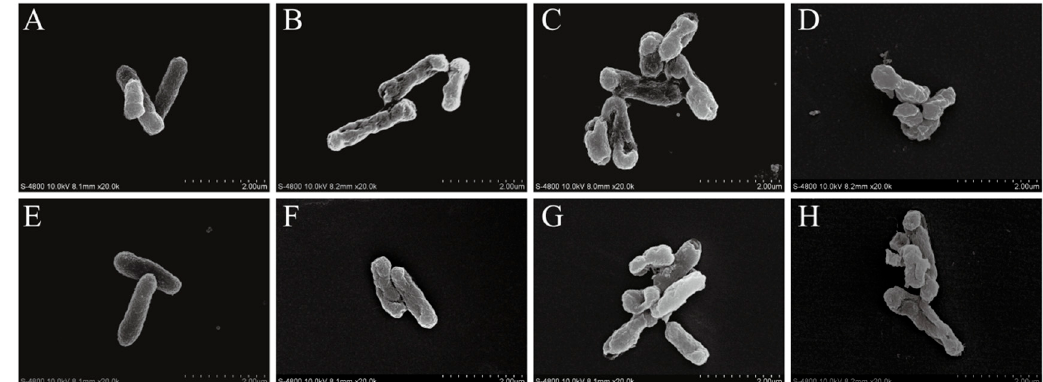
Figure 8. FESEM-based observations (20,000 × magnification) of untreated S. Typhimurium ATCC 14028 at 2 ( A ) and 4 h ( E ), and of S . Typhimurium ATCC 14028 treated with 0.2 mg/mL CoQ 0 for 2 ( B ) and 4 h ( F ); treated with 0.4 mg/mL CoQ 0 for 2 ( C ) and 4 h ( G ); and treated with 0.8 mg/mL CoQ 0 for 2 ( D ) and 4 h ( H ).